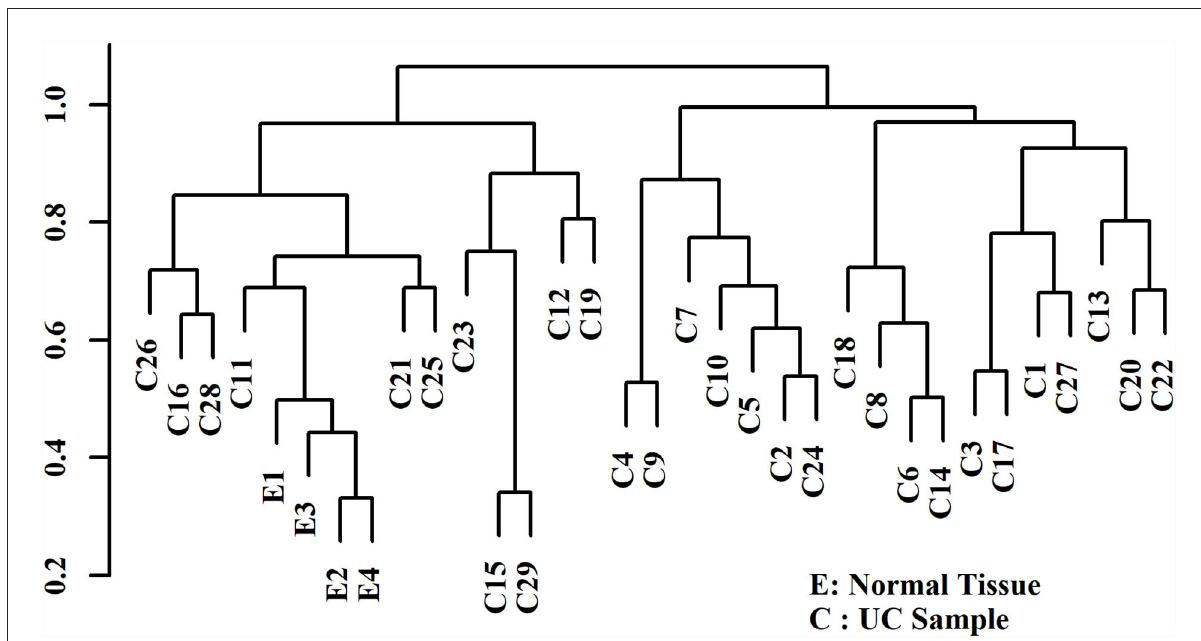
FIGURE1 Agglomerative hierarchical clustering with Pearson’s correlation distance displaying similarity of the control urothelial tissue samples (E1-4) relative to the invasive urothelial carcinoma samples (C1-29). The control urothelial tissue samples (E) demonstrate mutual similarity relative to the iUC samples